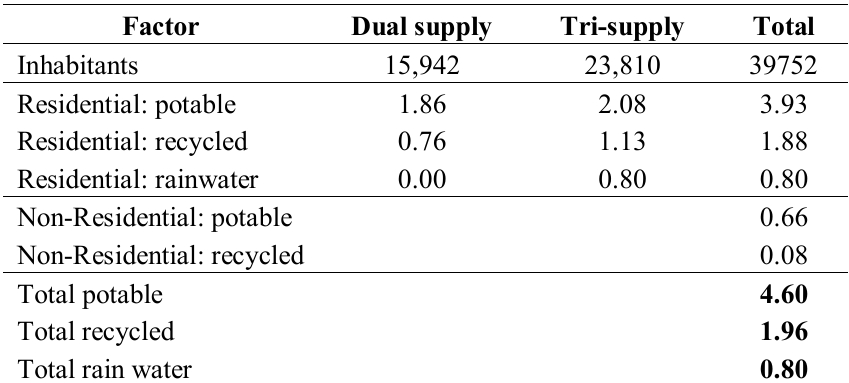
Table 1. Current water demand [ML/d]